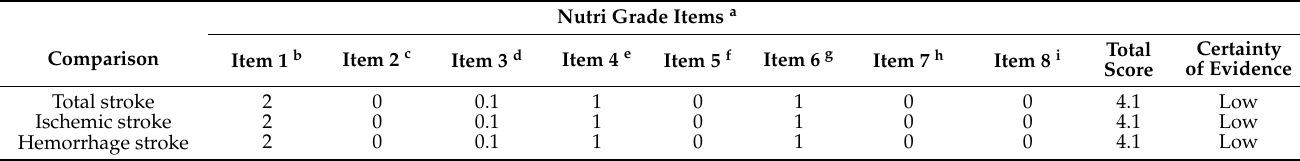
Table 3. Item-level scoring for the NutriGrade tool and certainty of evidence for association between a vegetarian diet and